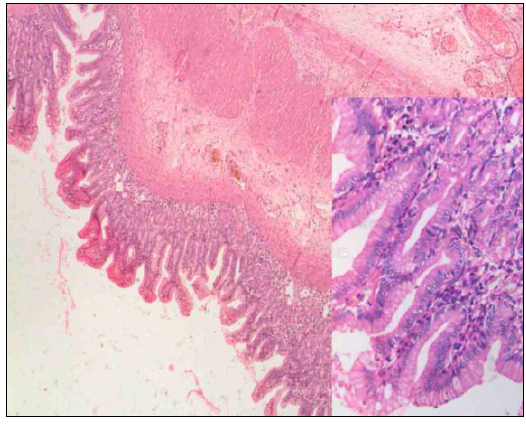
Figure 2: Histopathology showing ectopic gastric mucosa in the ileal